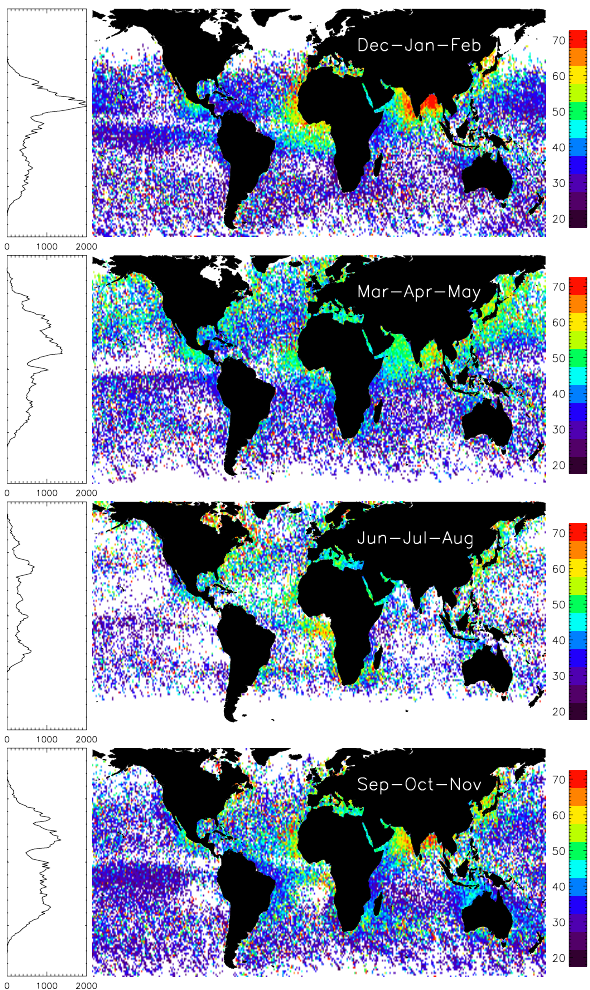
Fig. 5. Same as Fig. 4 but for the phase function slope at backscatter (see Eq.